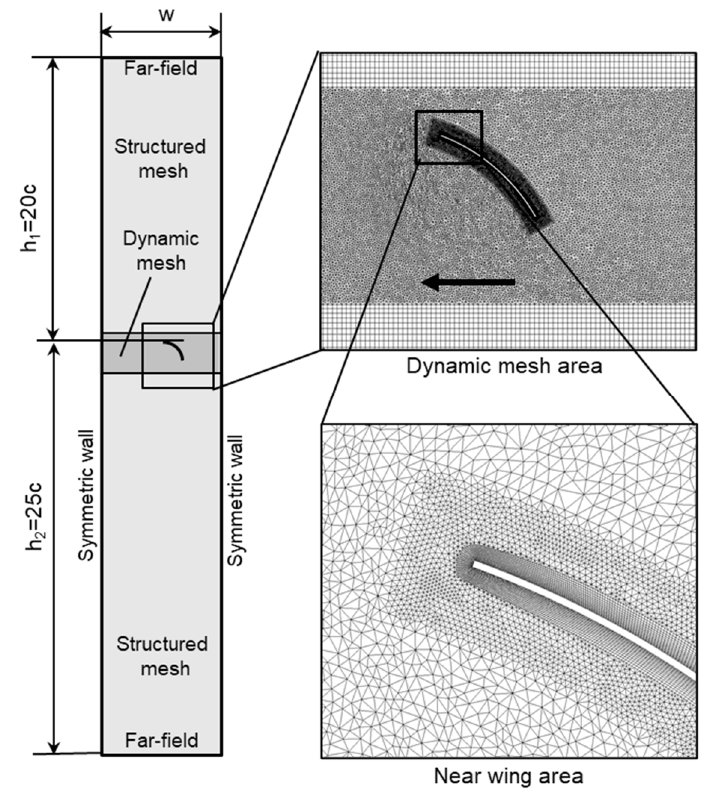
Figure 6. Two-dimensional computational domain.